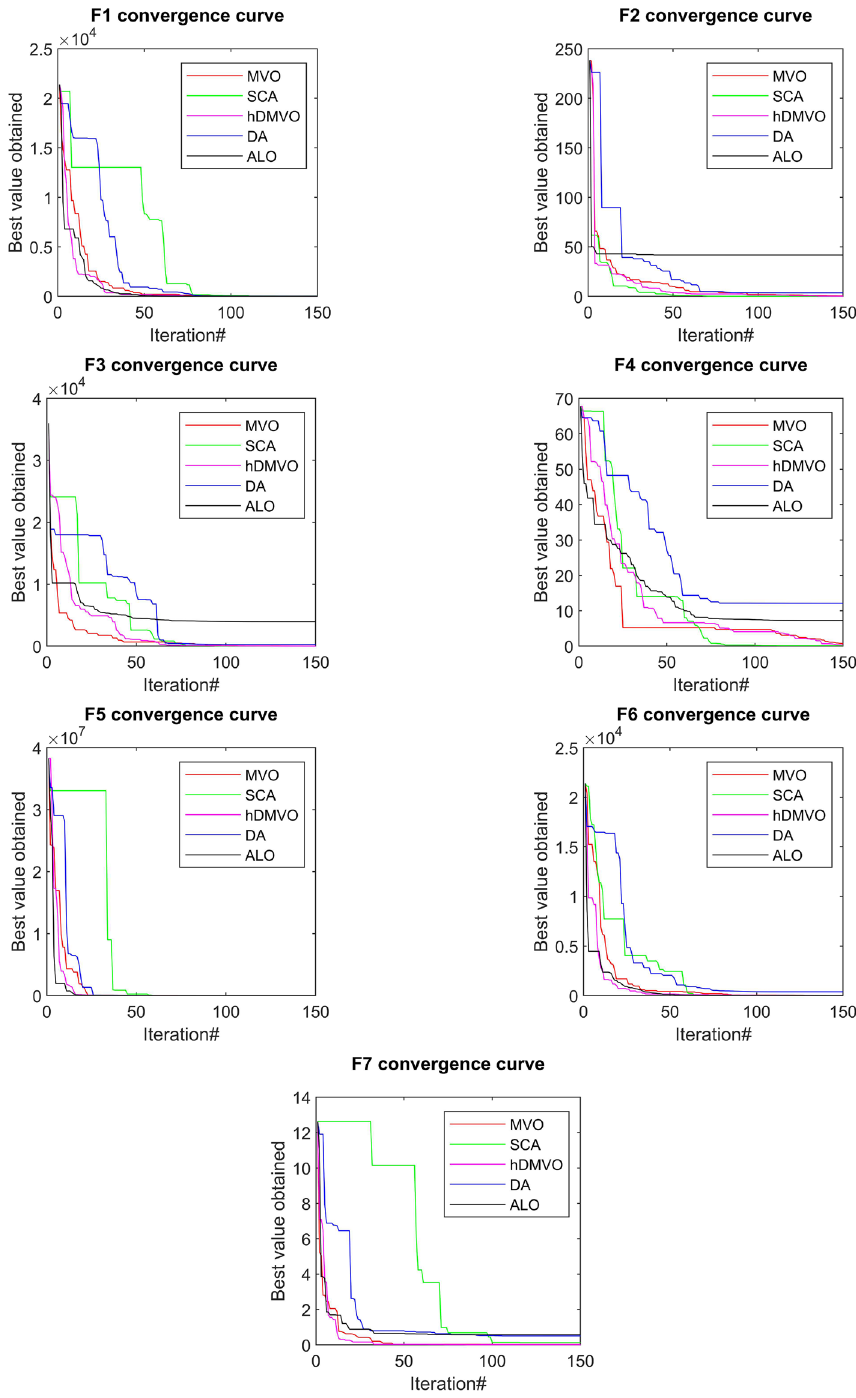
Figure 7. Convergence curves of MVO, SCA, ALO, DA, and hDMVO variants for unimodal